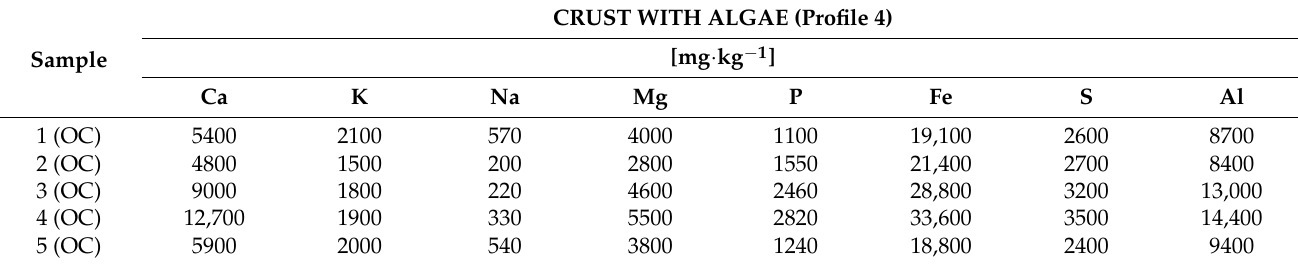
Table 5. Content of selected major elements in the algal crust. CRUST WITH ALGAE (Profile 4) [mg · kg − 1 ]